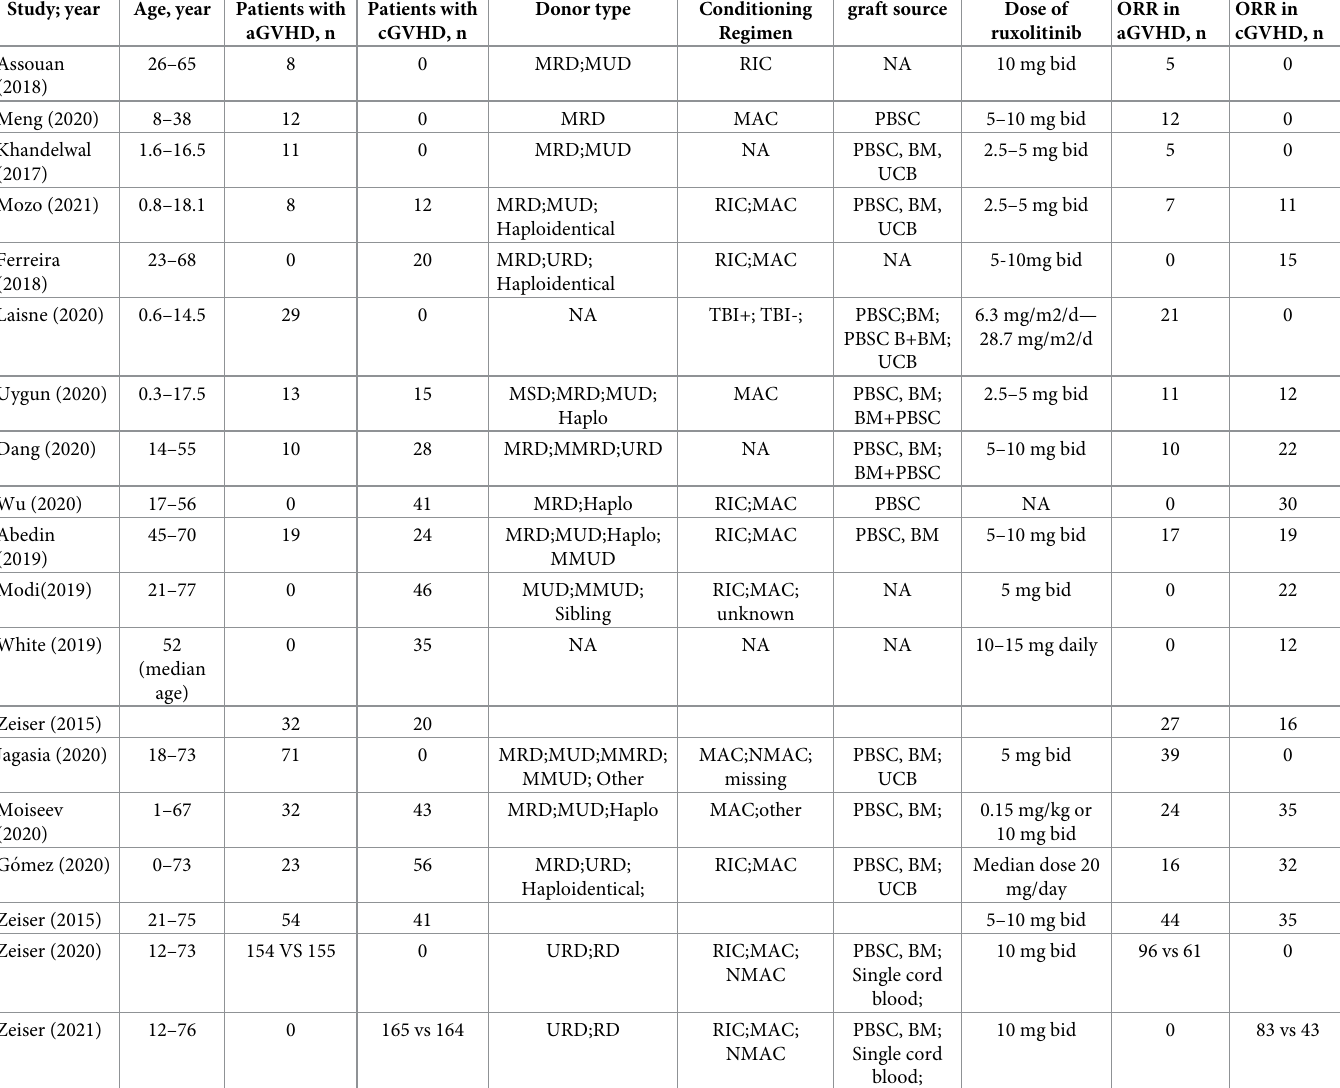
Table 1. Clinical characteristics of included studies of ruxolitinib evaluating survival, responses in SR-GVHD. Study; year Age, year Patients with aGVHD,